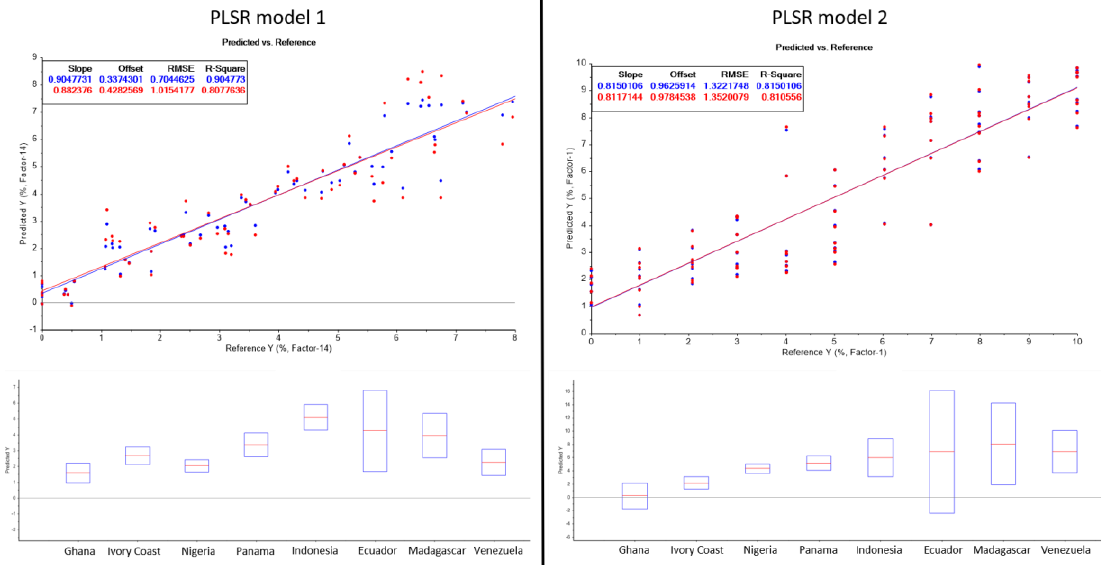
Figure 1. PLSR models of cocoa shell calibration series 1 and 2 and the results of the cocoa shell contents of 8 different samples from various origins calculated using the developed PLSR models. The parameters and results of the calculated PLSR models are shown in Table S5 in the supplementary materials. The samples were prepared by mixing cocoa nibs and cocoa shell powder as shown in